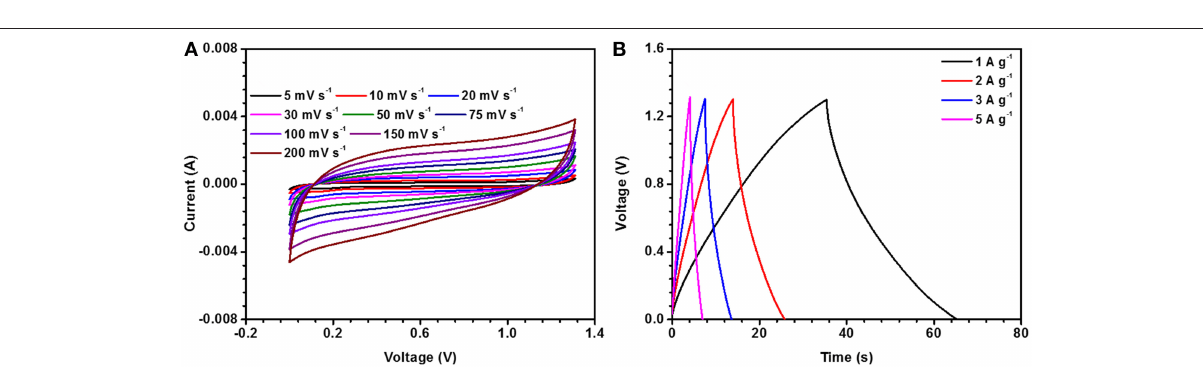
∼ 5.7 nm, would also allow better intercalation/ de-intercalation of electrolyte ions than the solid particles that showed pores of ∼ 1.7 nm radius. The surface area, pore size/volume, particle size distribution, and zeta potential of solid particles are depicted in Figures S10a–d